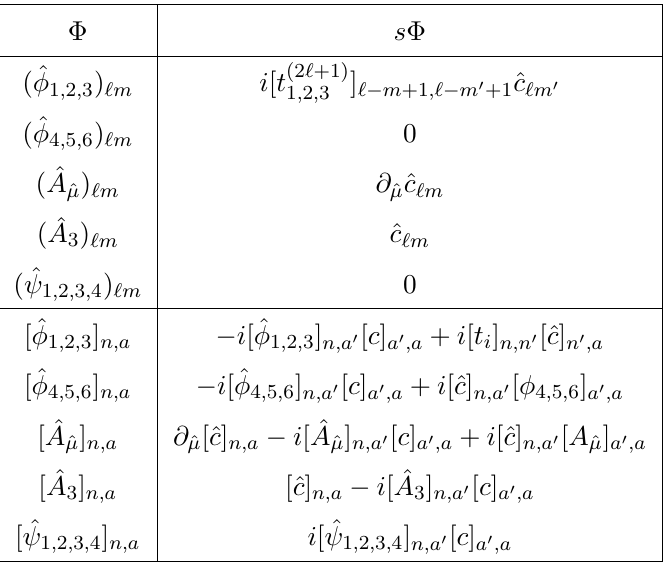
Table 2 . BRST variation of boundary (cid:12)elds.